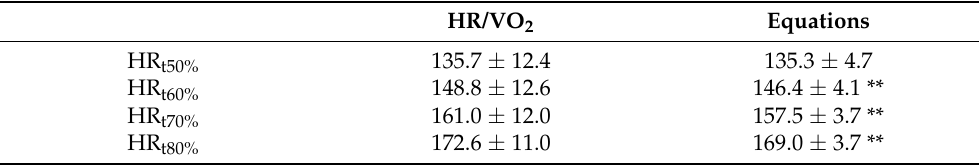
Table 3. Mean values and standard deviation of HR/VO 2 measured and HR estimated by the Table 5. Estimated values for the intensities of 50, 60, 70 and 80% of aerobic training compared to proposed equations for intensities of 50, 60, 70 and 80% for the regression group (GR). reference values (HR/VO 2 ) for individuals of both sexes in the cross-validation group (CVG). HR/VO 2 (bpm) HR equation (bpm) SEE (bpm) HR/VO 2 Equations HR t50% 135.7 ± 12.4 135.3 ± 4.7 HR t60% 148.8 ± 12.6 146.4 ± 4.1 ** 161.0 ± 12.0